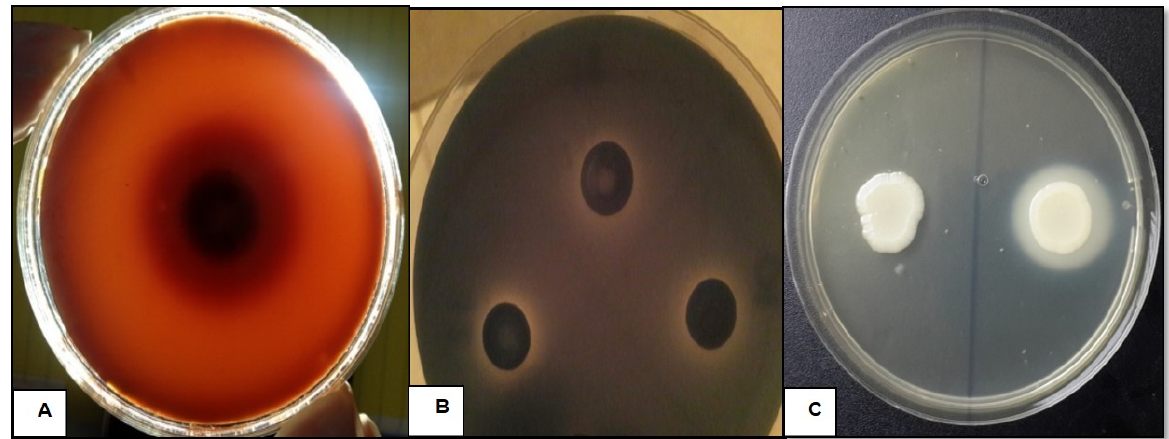
Figure 1. (A ) C. tropicalis on blood SDA showing dual hemolytic zones; ( B ) proteinase activity of C. tropicalis isolates; ( C ) C. tropicalis isolates showing positive (right) and negative (left) phospholipase activities on egg yolk-enriched SDA.